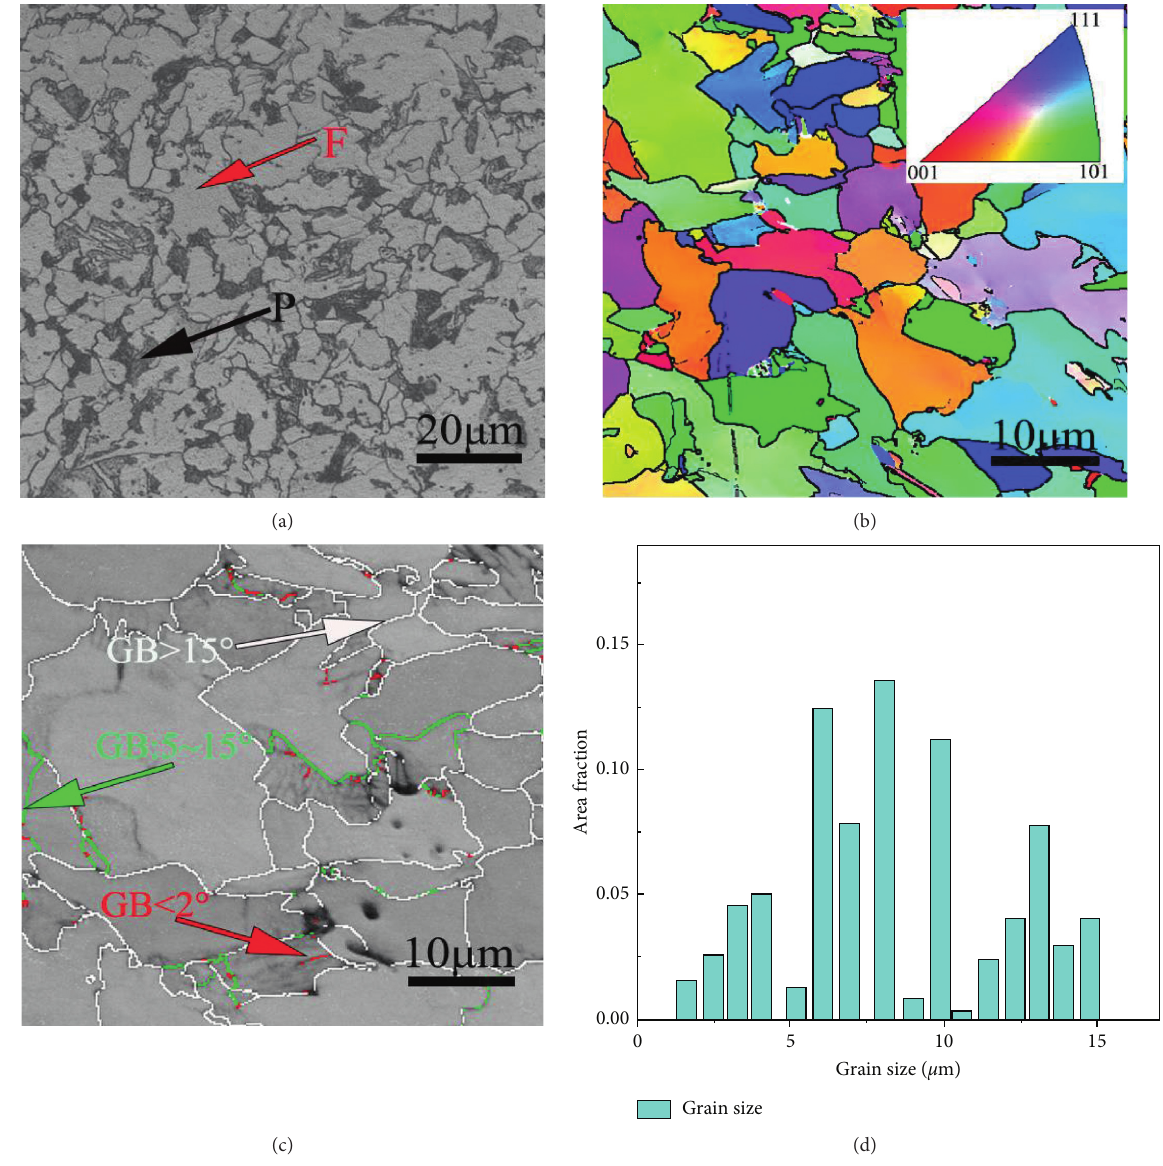
Figure 2: Microstructure and grain boundary of initial steel. (a) OM microstructure of initial steel, (b) IPF of initial steel, (c) grain boundary of initial steel, and (d) grain size of initial